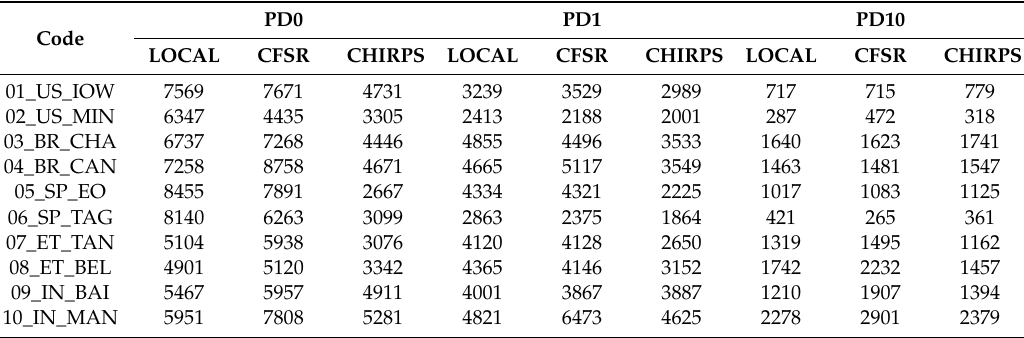
Table 5. Number of days with precipitation greater than 0 (PD0), 1 (PD1) or 10 (PD10) mm during the study period